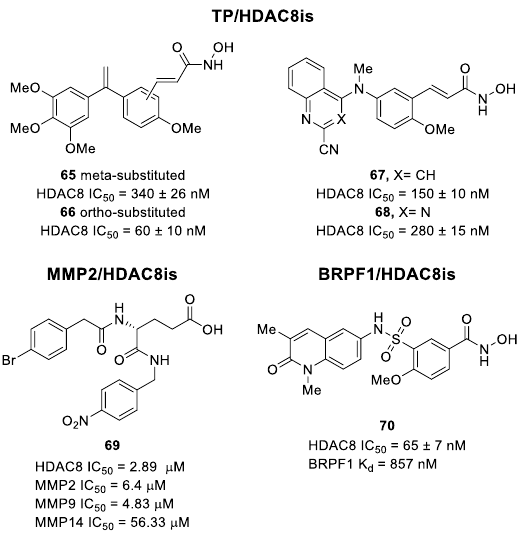
Figure 12. Representation of reported dual TP/HDAC8is, MMP2/HDAC8is and BRPF1/HDAC8is